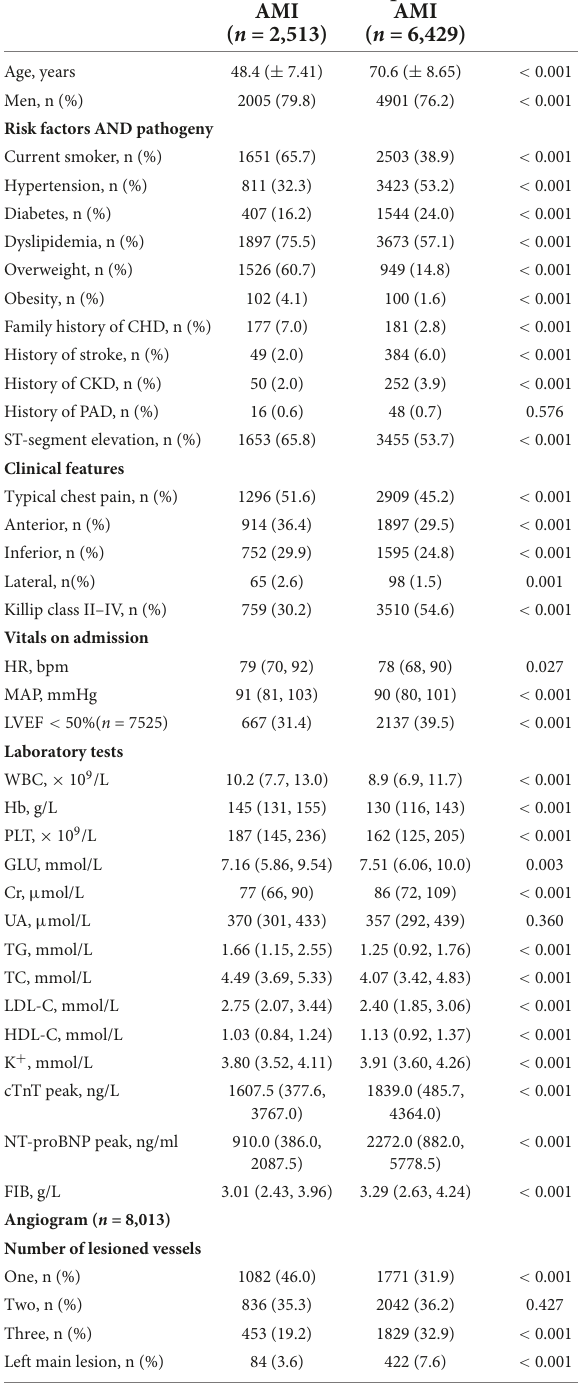
TABLE 1 Baseline demographic, risk factors, and clinical features by age.